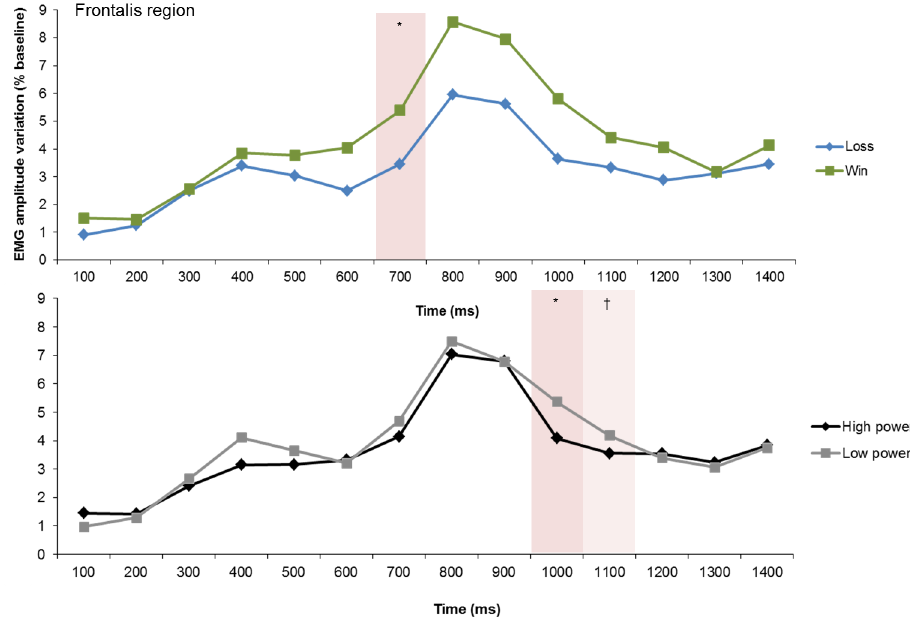
doi:10.1371/journal.pone.0135837.g008